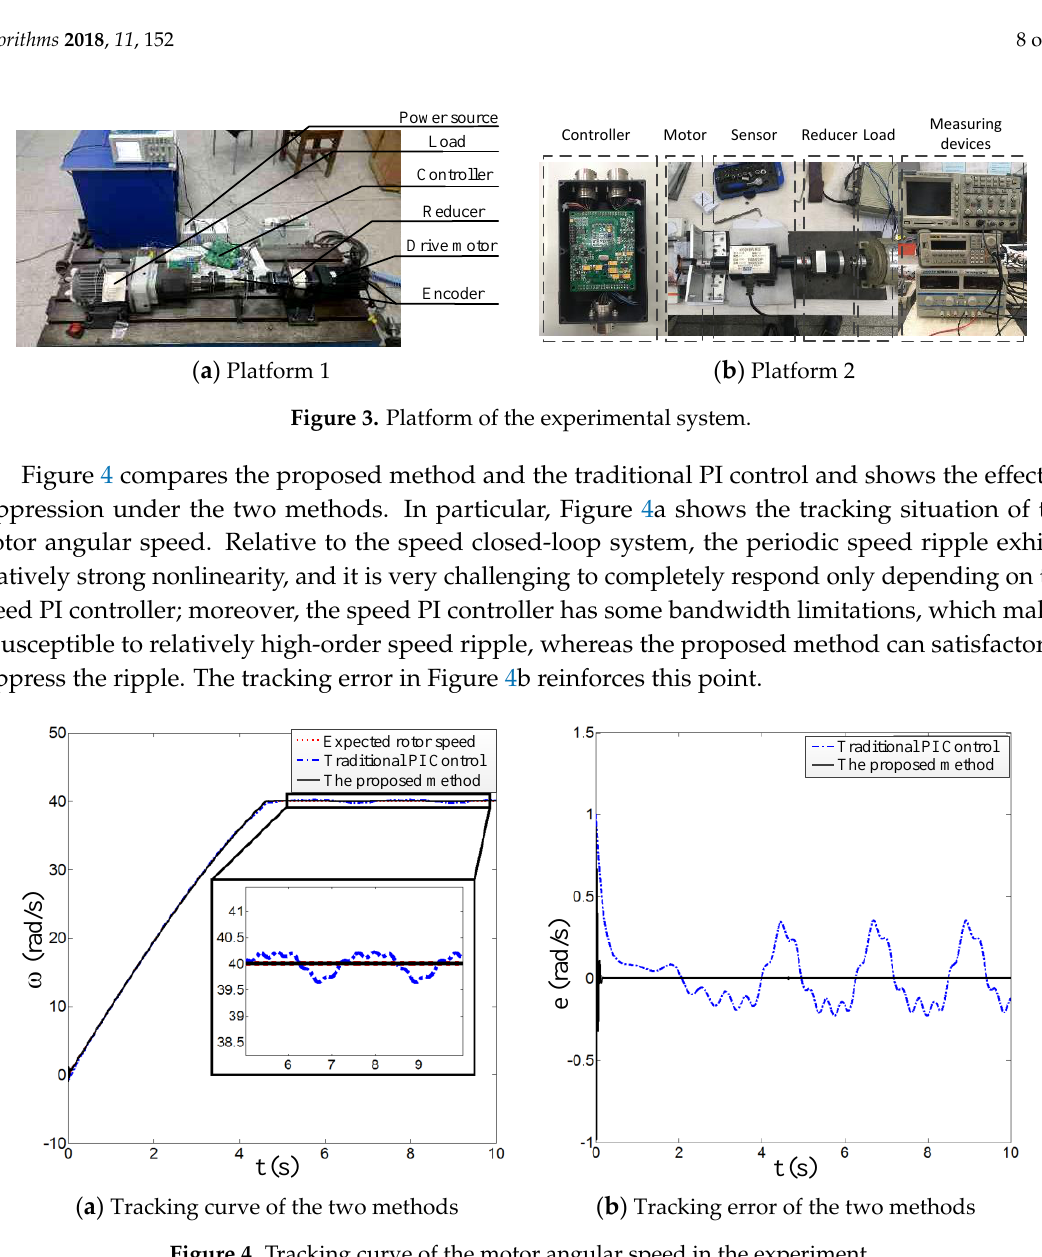
( f ) Sixth iteration Figure 2. Tracking curve of the motor angular speed in the simulation.